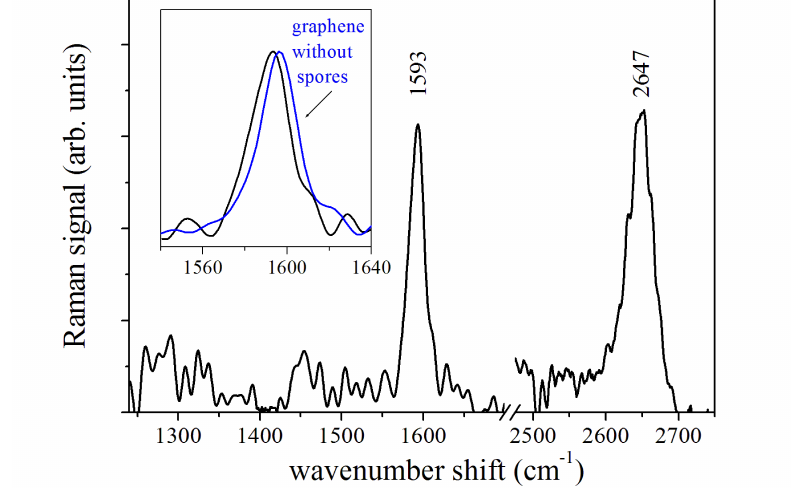
Figure 3. The Raman response of graphene. The ν G mode region of the spectrum of graphene in contact with spores after the exposure to T e = 200 K is compared in the inset with the Raman response without spore (curve blue). The ν G energy of the spectrum shifts to lower values, indicating an alkalinity increase (pH = 10.2 ± 0.7) of the graphene with spores.